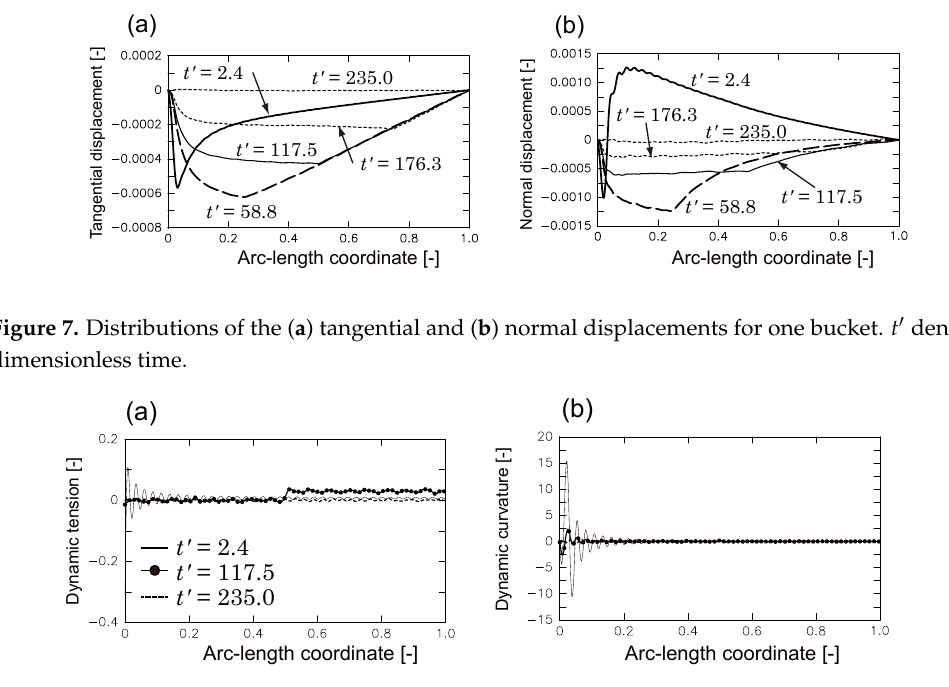
Figure 6. Temporal changes in the generalized coordinates of the lowest four modes for one bucket: ( a ) tangential component and ( b ) normal component.